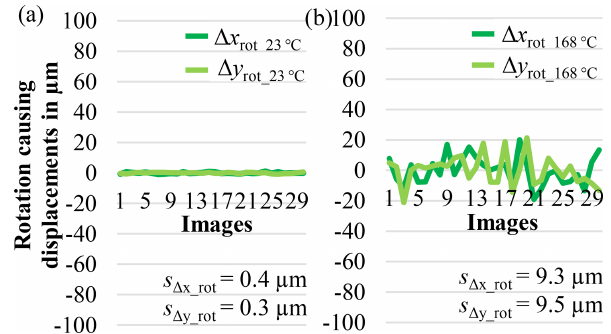
Figure 11. Rotation causing displacements of rotatory components (cid:49)x rot and (cid:49)y rot of the reference pipes at (a) room temperature ( ∼ 23 ◦ C) and (b) process temperature ( ∼ 168 ◦